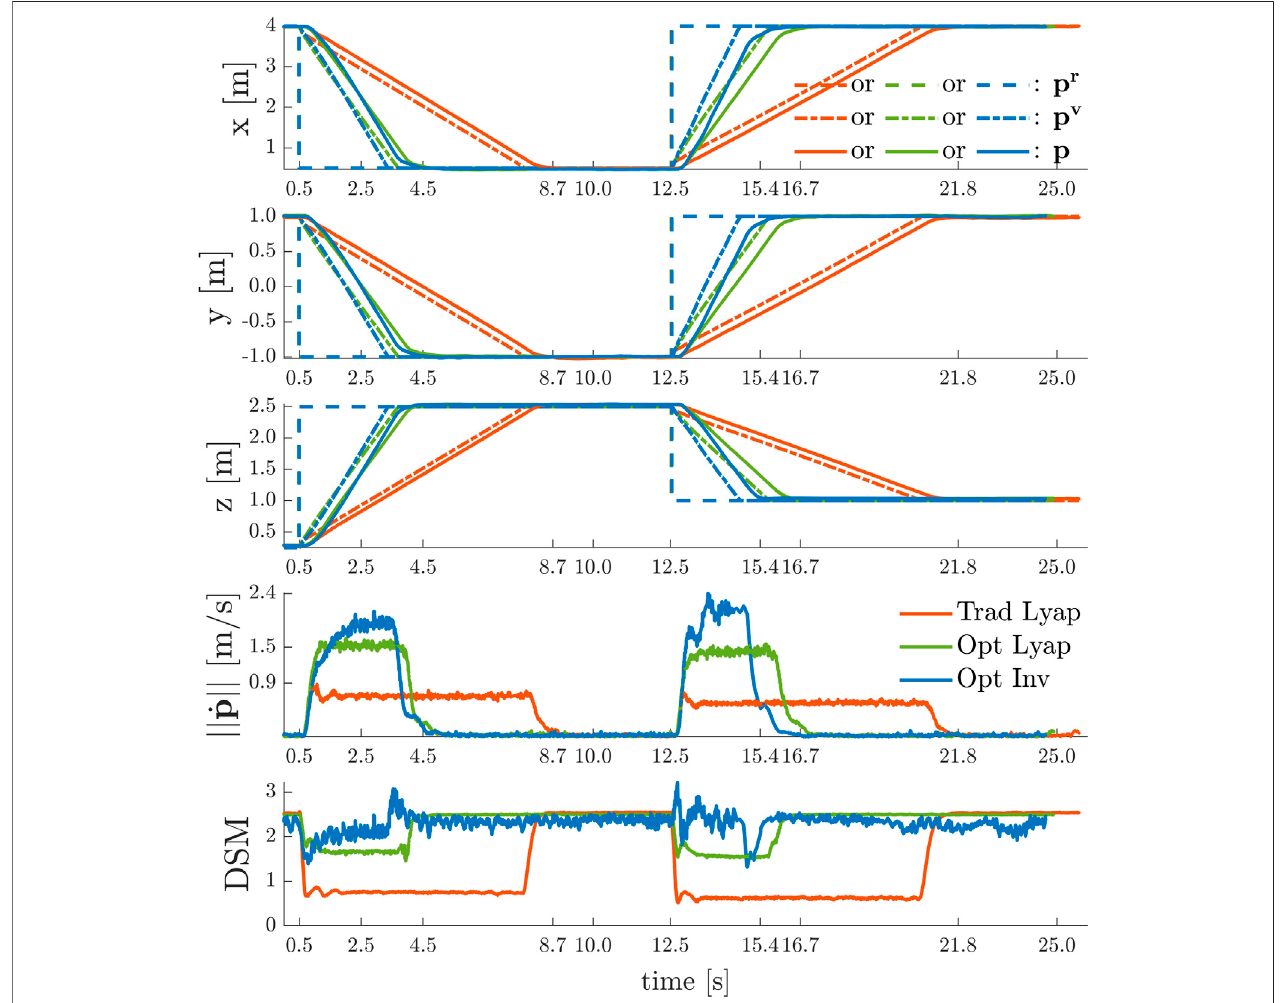
FIGURE8| Point-to-PointTransitionsWithoutViolationofInputConstraints − ThethreestrategiesforcomputingDSMsgiveprovablystableandsafeperformance.The traditional Lyapunov strategy is the most conservative one, whereas the invariance based strategy outperforms the other two in terms of settling time and peak velocity.